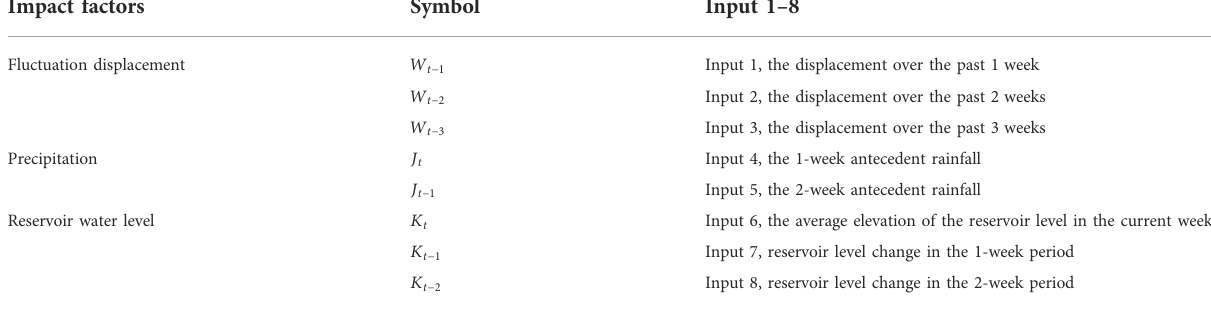
TABLE 1 Inputs for the modeling of the fl uctuation displacement.